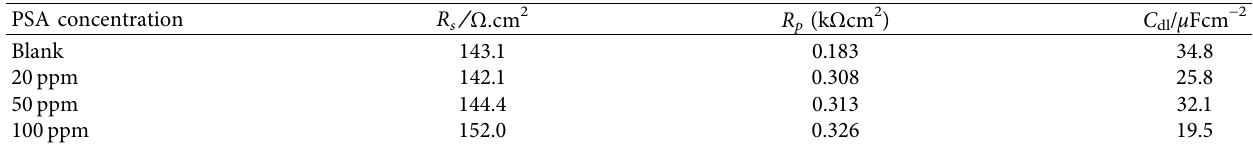
Figure 15: Equivalent circuit model for a simple electrochemical cell (Randles model). Table 6: Equivalent circuit parameters for a mild steel electrode after immersion for 1hr in a stagnant naturally aerated solution of 1 M H 2 SO 4 at diferent concentrations of PSA at 25 C.